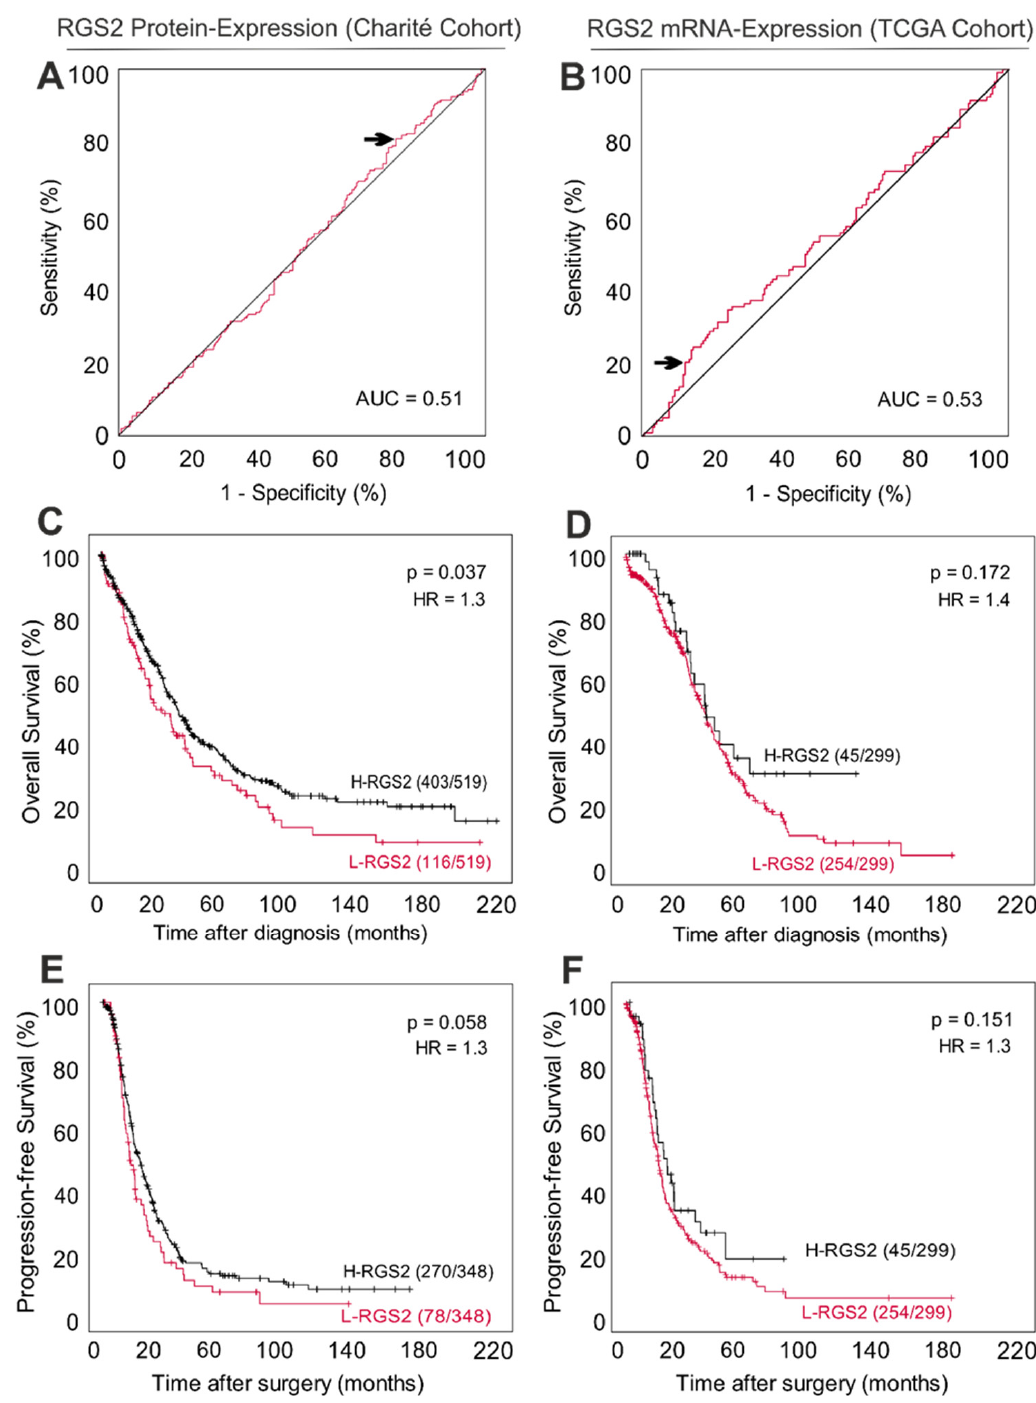
Figure 2. Low RGS2 expression indicates poor survival in HGSOC. ( A ) ROC curve determining best discrimination thresholds of RGS2 protein expression (percent of tumor cells) in the HGSOC Charit é -cohort. ( B ) ROC curve determining best discrimination threshold of RGS2 mRNA Expression in the HGSOC TCGA cohort. The arrow indicates chosen value for binary classification. AUC, area under curve. ( C , E ) Overall- and progression-free survival for patients with low and high RGS2 protein expression within the Charit é cohort. ( D , F ) Overall and progression-free survival for patients with low and high RGS2 mRNA-expression within the TCGA cohort. p -value indicates log rank test result, L-RGS2/H-RGS2: low/high expression of RGS2. HR: hazard ratio. Table 2. Multivariate Cox regression model for OS and PFS in HGSOC patients with regard to im- munohistochemical RGS2 protein expression in tumor cells and other factors with univariate signif- icance.